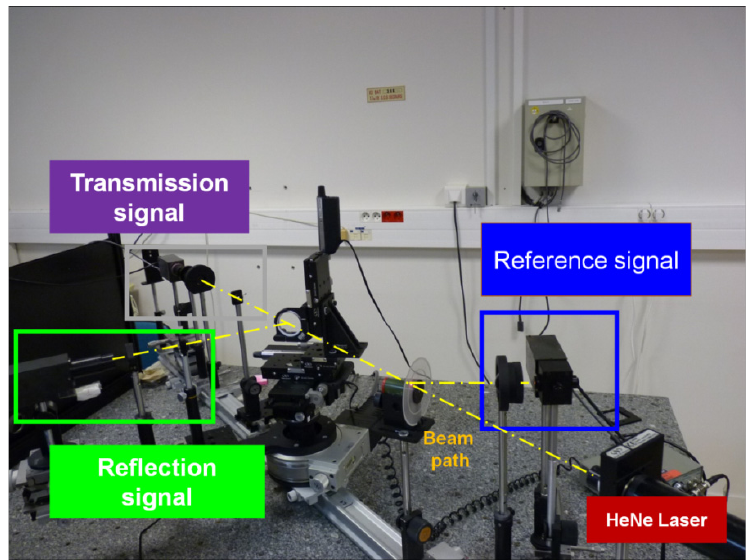
Figure 3. Scheme of the experimental ellipsometer.